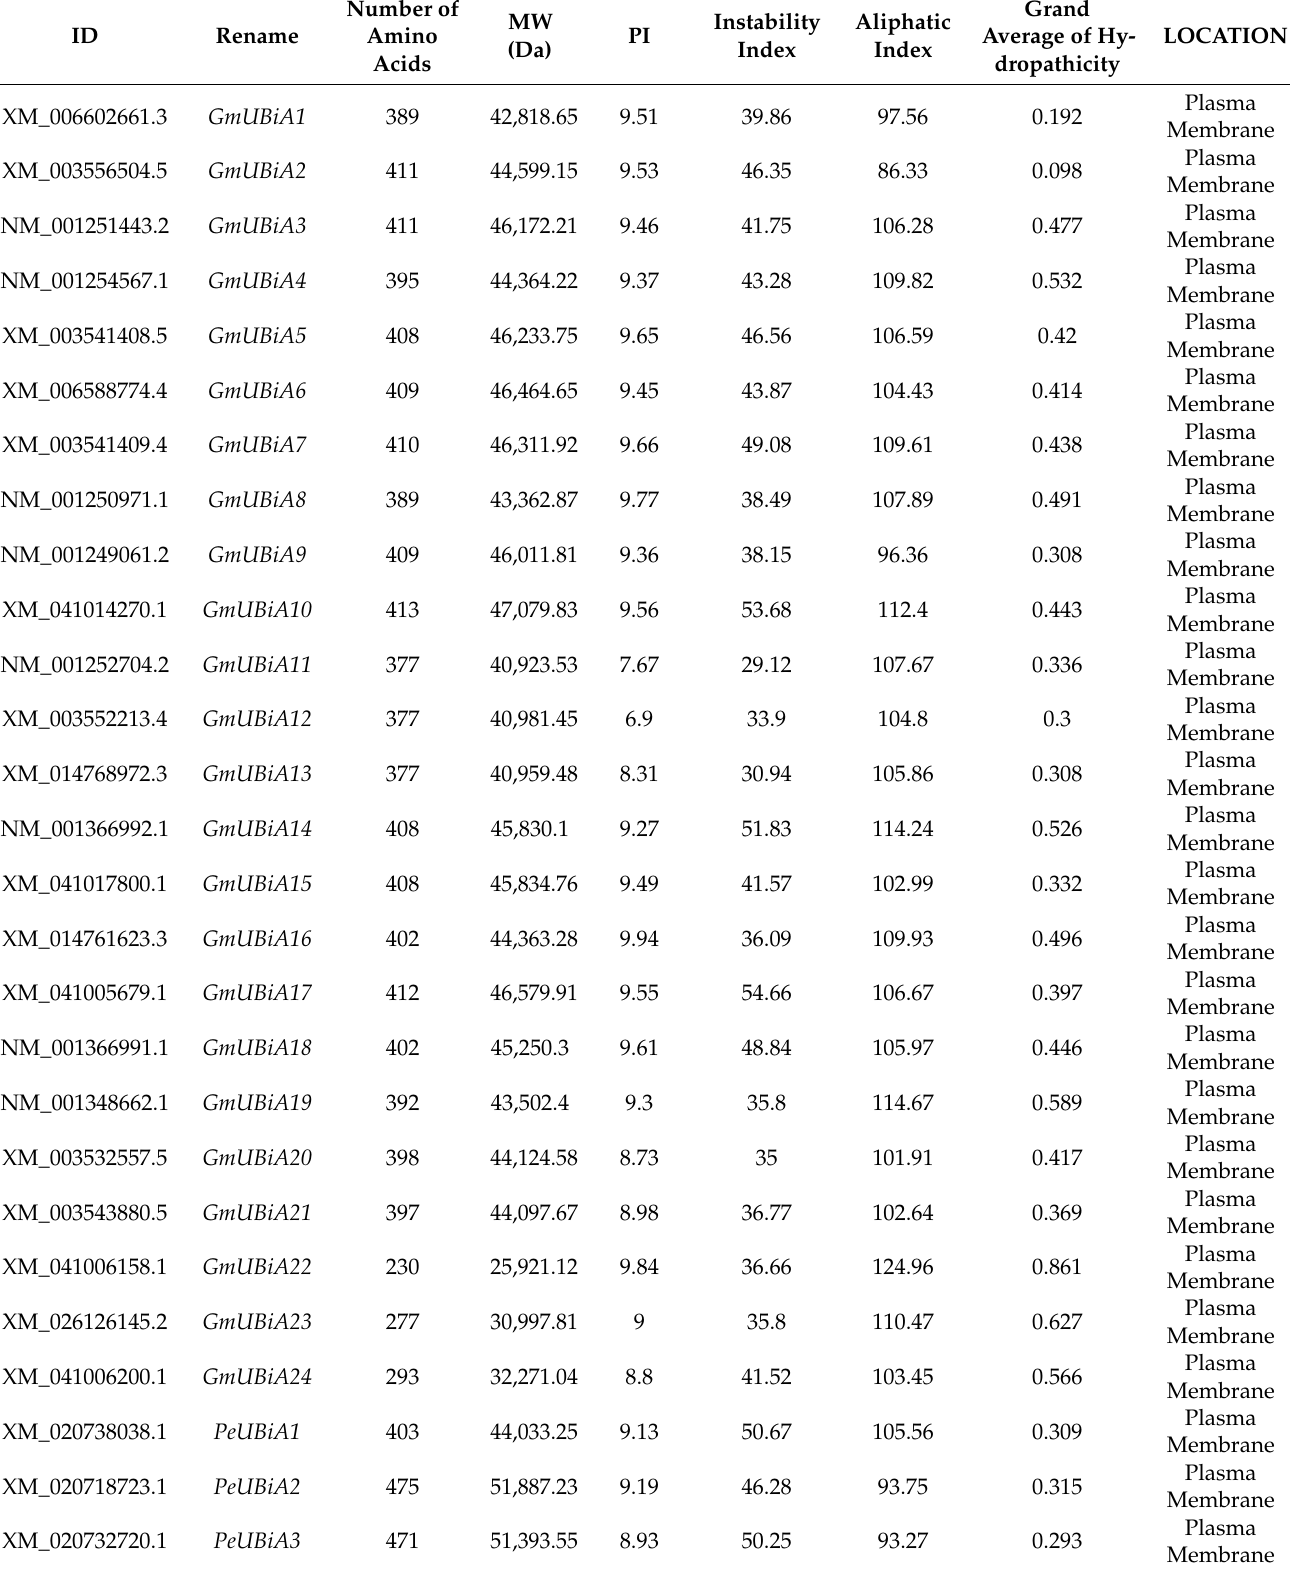
Table 2. The characteristics of UBiA family